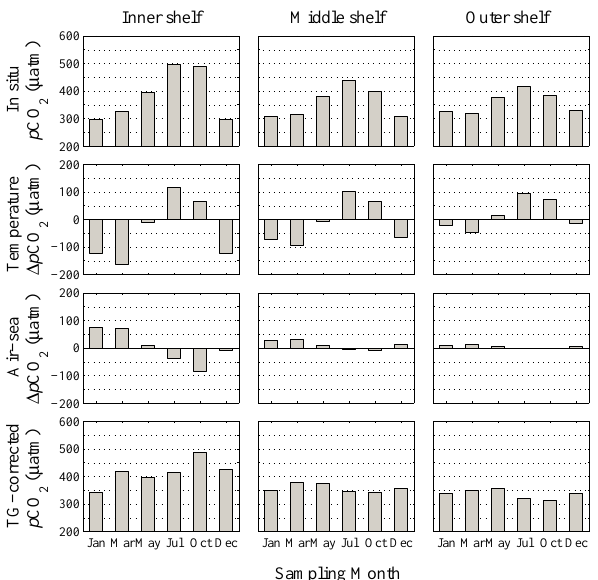
Fig. 5. Seasonal changes of area-averaged sea surface p CO 2 , p CO 2 variations due to temperature deviation from the annual mean tem- perature (23.11 ◦ C), p CO 2 variations due to air–sea gas exchange, and TG-corrected p CO 2 on the SAB. In situ p CO 2 is the sum of p CO 2 variations due to temperature, p CO 2 variations due to air– sea gas exchange, and TG-corrected p CO 2 (see Eq. 1 in text).